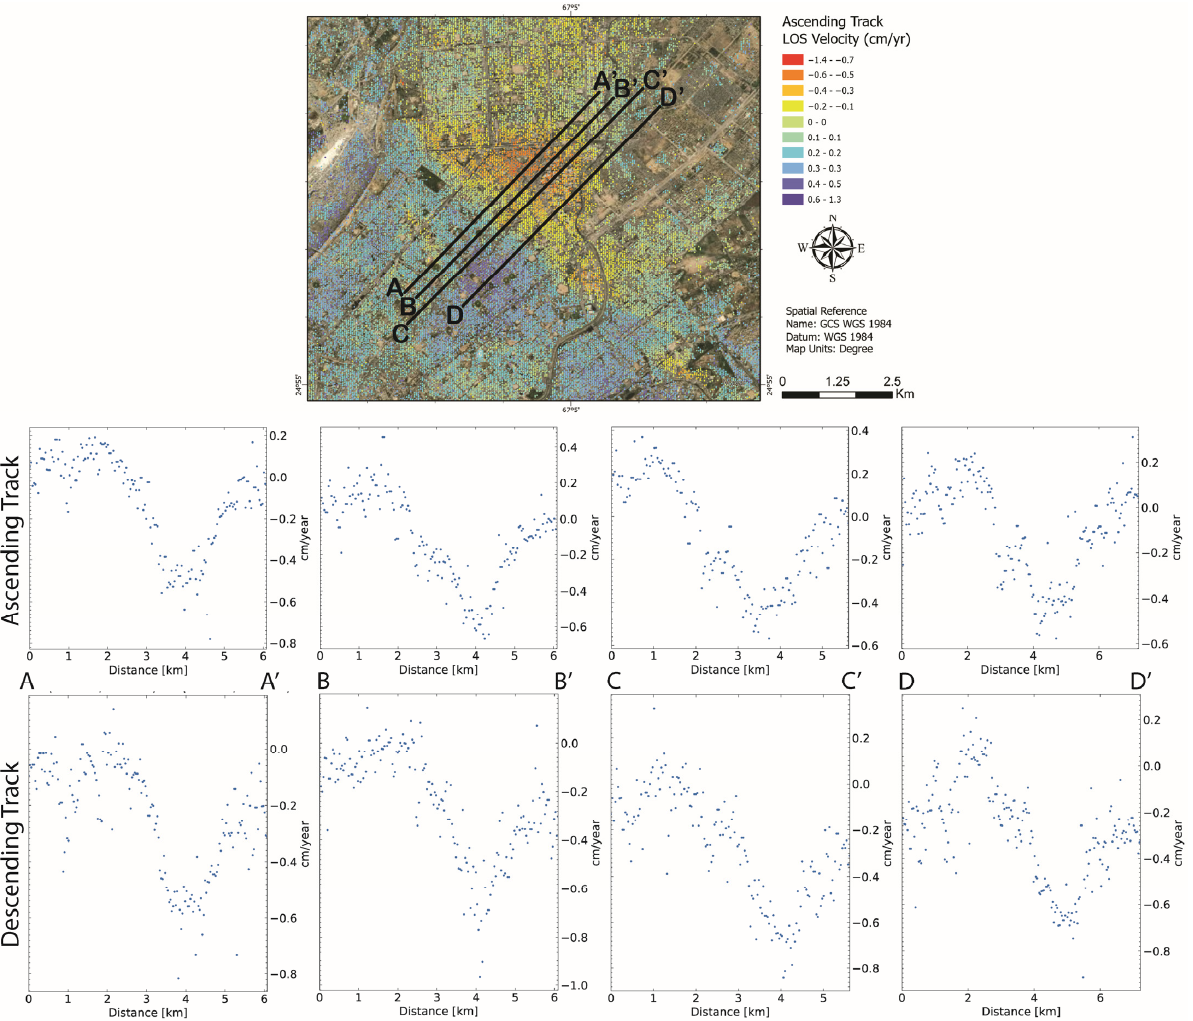
Figure 7. Transection plots across transition boundary for both ascending and descending track LOS velocity change results. Each plot is denoted with the start and end point (e.g., A to A’) corresponding to the line and direction seen in the map view above. Analysis of a perpendicular seismic line from the Union Texas 1999 2D seismic re- flection survey of Karachi shows clear displacement between reflectors and onlapping bedding planes consistent with listric normal fault geometry (Figure 8). We use the Geo- detic Baysian Inversion Software (GBIS) [41] to model the fault parameters using InSAR LOS velocity data from both tracks. Optimal fault model parameters determined a strike of 278° and a slip at depth of about 9.9 cm over 1,000,000 trials. The model results can be seen in Table 1.